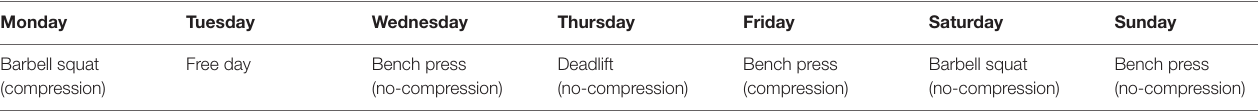
TABLE 4 | A sample training program of the Polish, World, and European champion in powerlifting